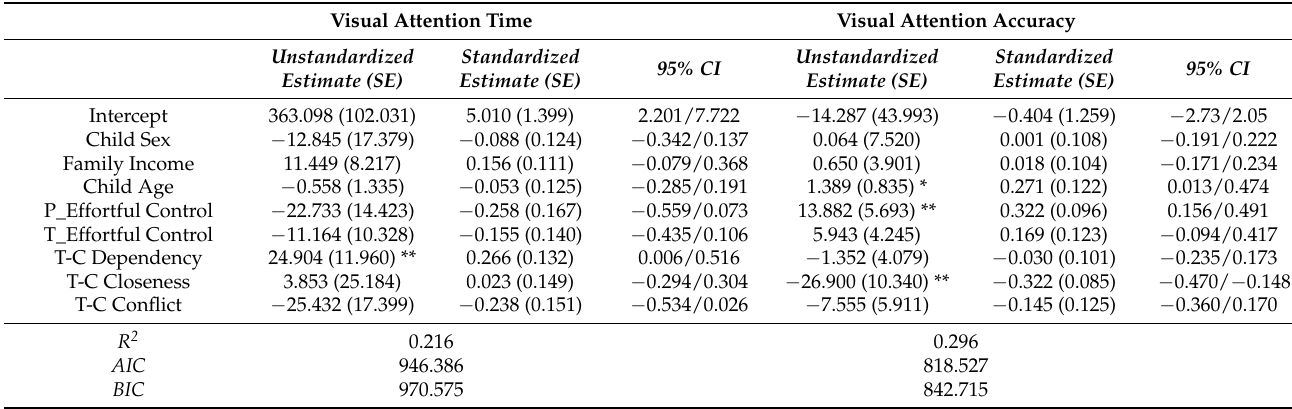
Table 2. Final model parameters for effortful control and teacher–child relationships predicting children’s visual time and